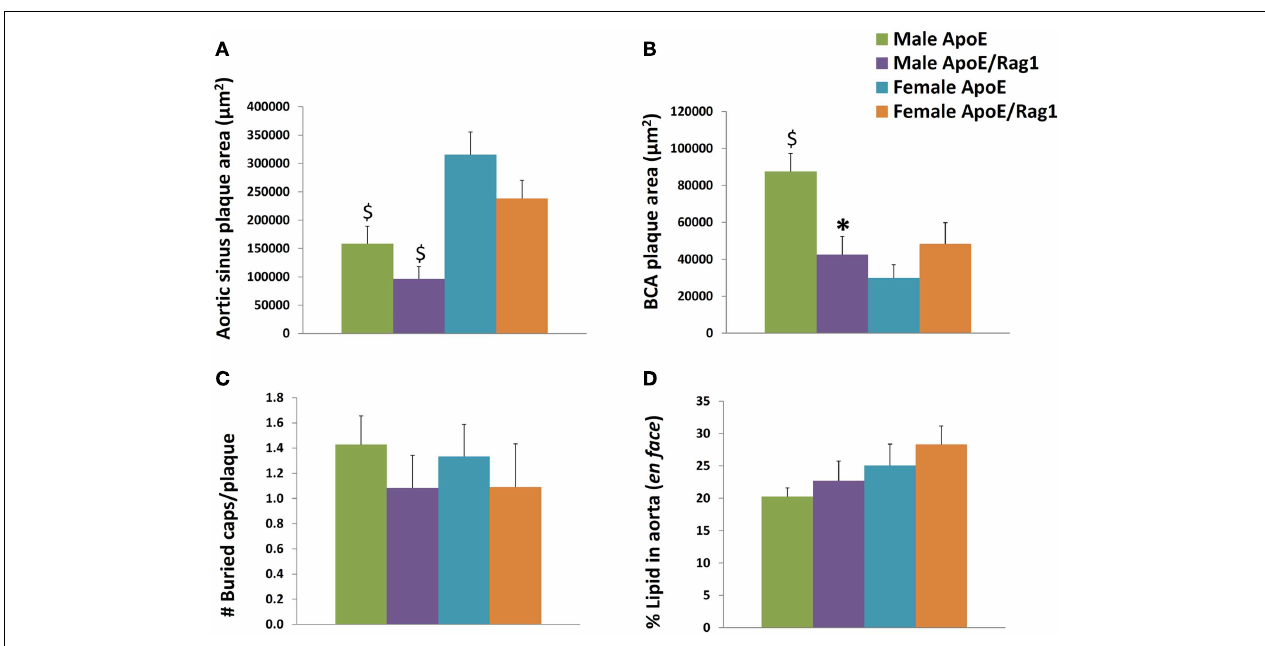
examined in a similar fashion to A, n = 13–19. (C) The number of buried layers in plaque from BCA were assessed in EVG and α -SM-actin stained sections, n = 11–14. (D) Whole aorta were opened longitudinally and stained en face for the presence of neutral lipid using Oil-Red-O.The area of lipid-rich plaque in each aorta was calculated using computer aided planimetry, n = 10–11.Values are expressed mean and SEM. * P < 0.05 vs. DKO, $ P < 0.05 indicates gender differences for that